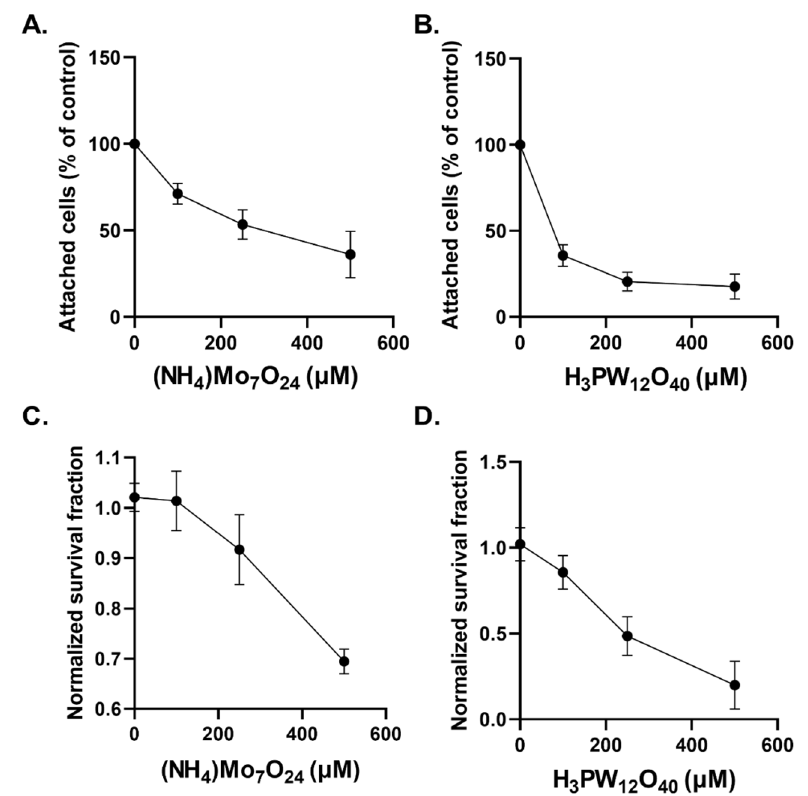
Figure 2. Tungsten- and molybdenum-containing POMs have cytostatic and cytotoxic effects in GBM cells. The number of attached cells were counted following a 48 h treatment of U87 glioblastoma cells treated with increasing concentrations of (NH 4 )Mo 7 O 24 ( A ) and H 3 PW 12 O 40 ( B ). Following the 48 h treatment with increasing concentrations of (NH 4 )Mo 7 O 24 ( C ) and H 3 PW 12 O 40 ( D ), U87 cells were replated as single cells to evaluate their clonogenic potential.